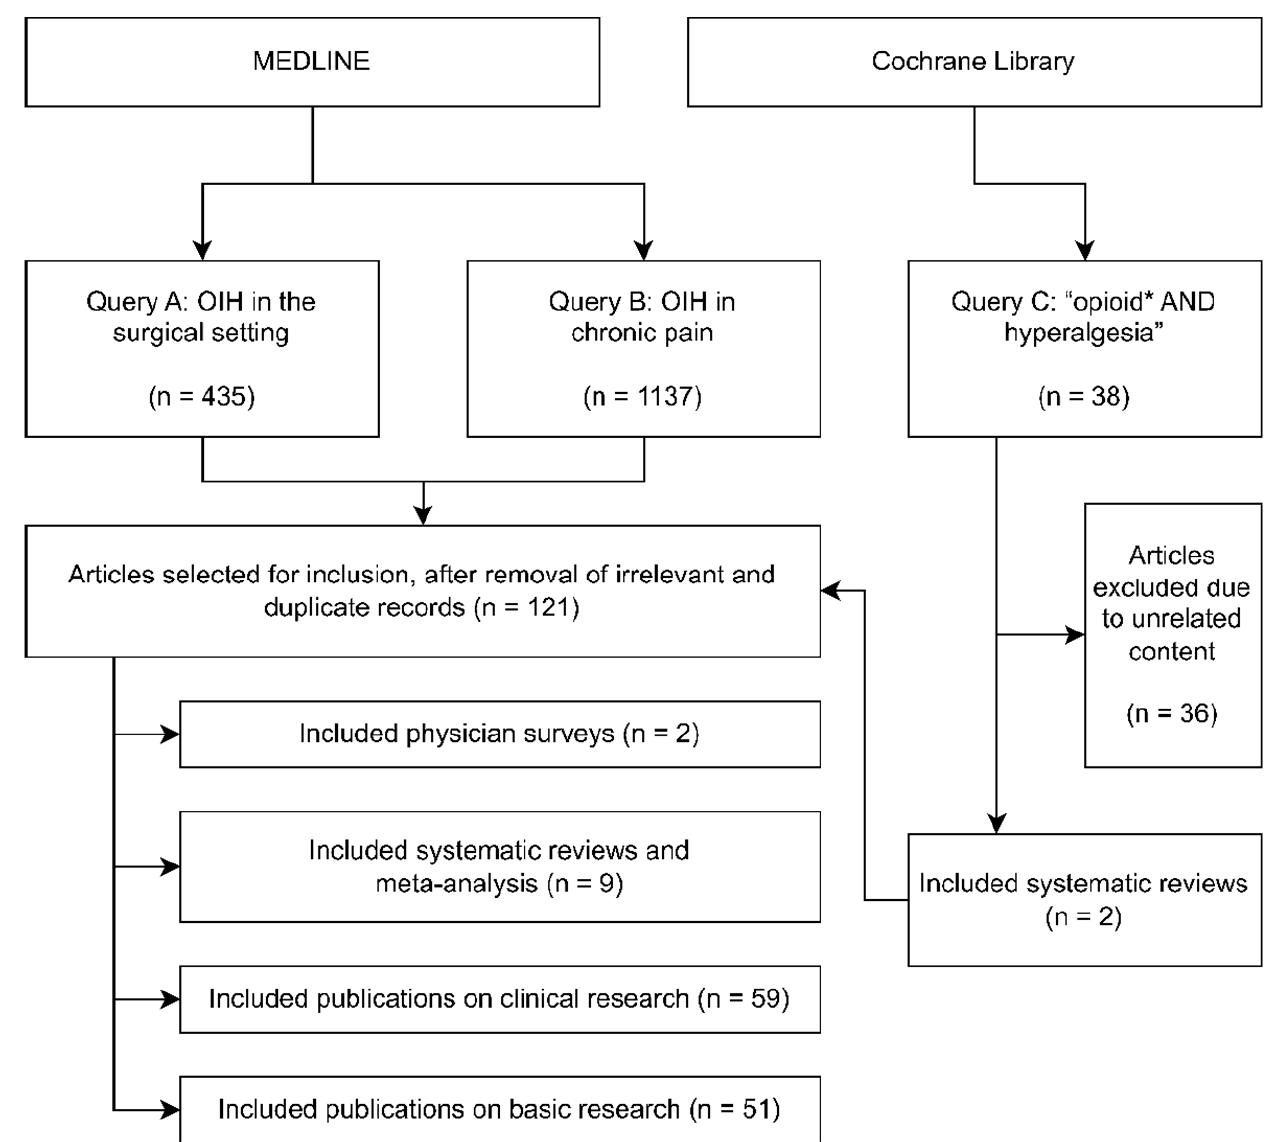
Figure 1. Flowchart depicting the selection of relevant literature.